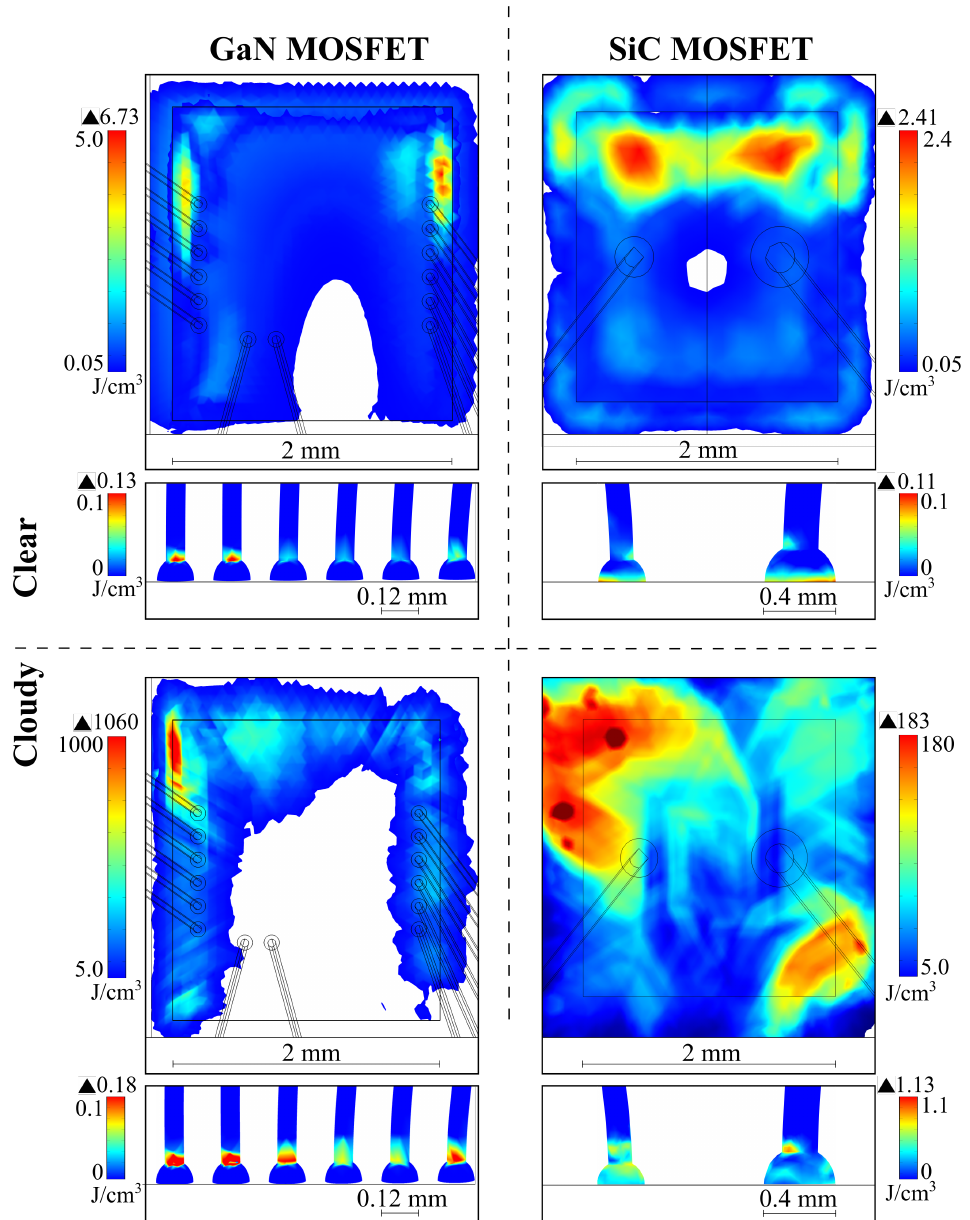
Figure 12. Plastic energy dissipation density surface plots of the die attach and bond wires of the GaN MOSFET and the SiC MOSFET after being stressed by the one-hour mission profiles from Figure